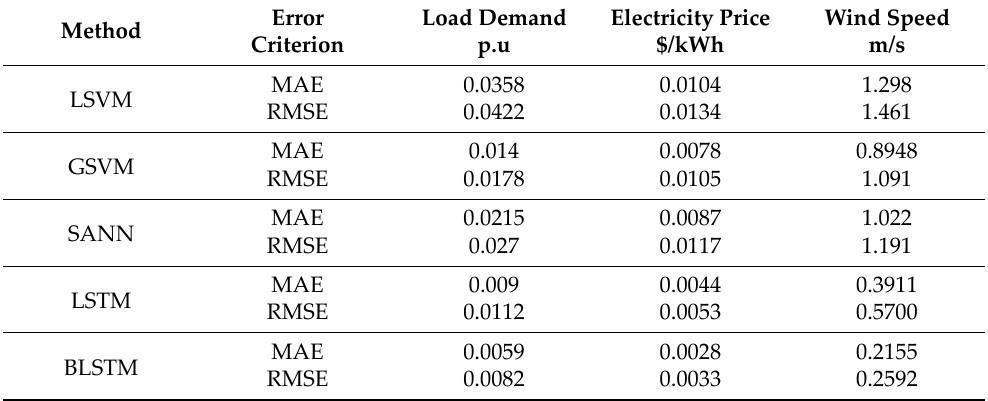
Table 7. Forecasting error criteria for different methods.